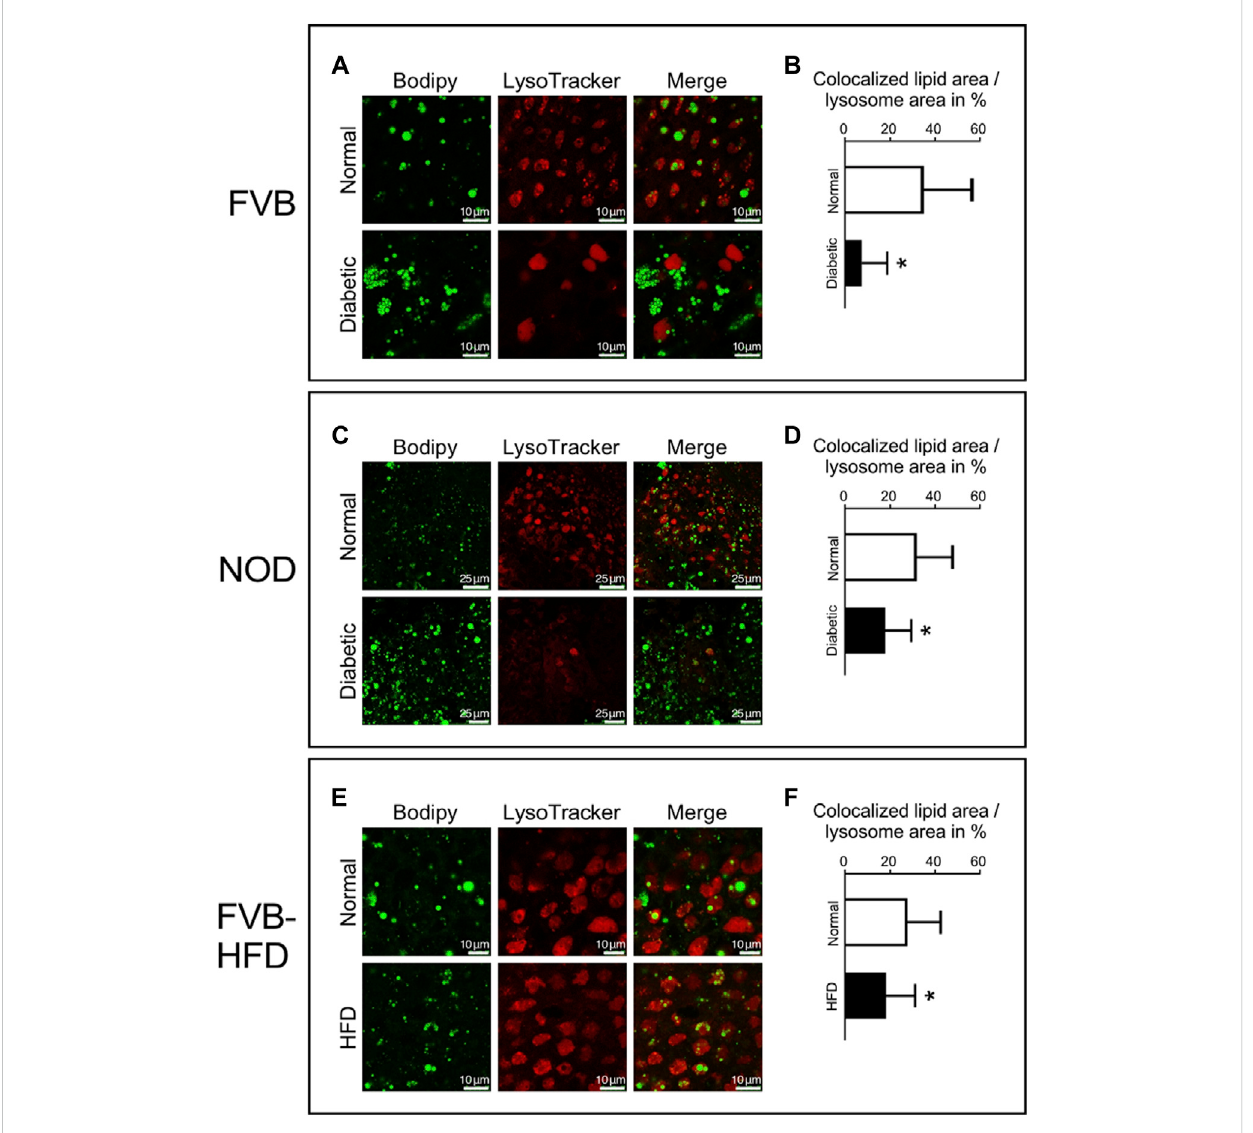
FIGURE 5 Decreased colocalization of lipid droplets and lysosomes in yolk sacs from diabetic and obese pregnancies. Live yolk sac tissue was stained with LysoTracker dye and Bodipy. Panel A : Yolk sac from normoglycemic and diabetic FVB pregnancies; bigger lipid droplets were observed in the lumen of lysosomes in the normal yolk sac. Panel B : The areas depicting lipid droplets colocalized with lysosomes were identi fi ed and quanti fi ed, and the areas of the corresponding individual lysosomes were measured. The ratios of the areas occupied by colocalized lipid droplets over the corresponding individual lysosome areas were calculated (depicted in %). Lipid droplet colocalization with lysosomes was signi fi cantly decreased in yolk sacs from diabetic FVB dams. Sample size: N = 18 yolk sacs from 5 normoglycemic FVB dam pregnancies, n = 16 yolk sacs from 6 diabetic FVB dam pregnancies. Panel C : Yolk sacs from normoglycemic and diabetic NOD pregnancies were analyzed for lipid droplet colocalization with lysosomes (smaller magni fi cation than Panel A). Panel D : Quanti fi cation reveals that lipid droplet colocalization with lysosomes was signi fi cantly decreased in yolk sacs from diabetic NOD dams (n = 18 yolk sacs from 6 diabetic NOD pregnancies) when compared to normoglycemic NOD pregnancies (n = 21 yolk sacs from 5pregnancies).Panel E :Lipiddropletcolocalizationwith lysosomes analyzedinyolksacsfromchow-andhigh-fat-diet-fedFVBpregnantdams.Panel F : Lipid droplet colocalization with lysosomes was signi fi cantly decreased in yolk sacs from HFD-fed pregnant FVB dams (n = 14 yolk sacs from 4 pregnancies) when compared to yolk sacs from chow-fed FVB pregnancies (n = 18 yolk sacs from 5 pregnancies). Data presented as mean ± SD, fi rst averaged over each pregnancy, then for each respective experimental group; asterisks indicate p < 0.05, when comparing experimental and control groups using two-tailed t-tests.